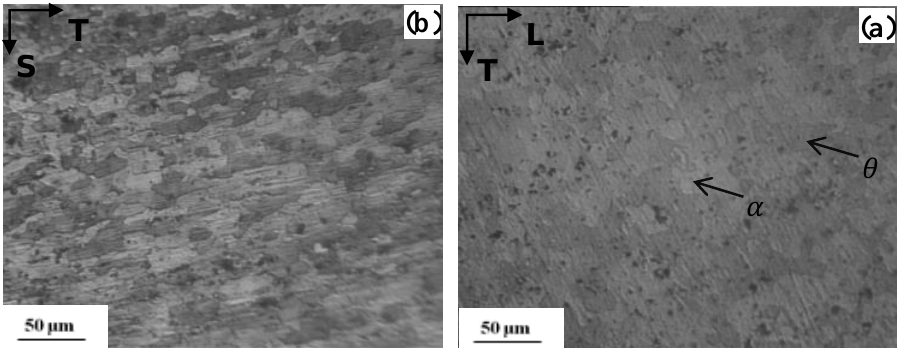
Fig. 2. Optical micrograph of the 2017A-T4 aluminum alloy (as-received